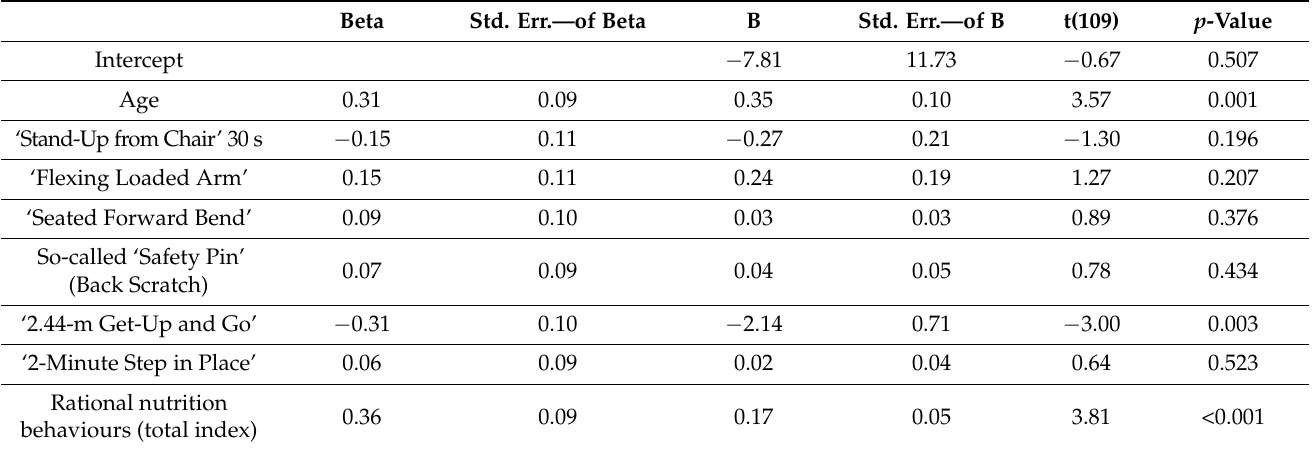
Table 5. Regression analysis—full